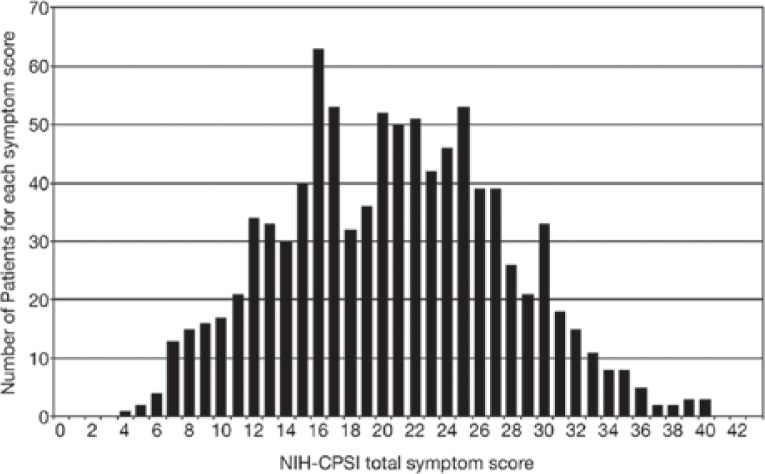
Distribution pattern of total National Institutes of Health-Chronic Prostatitis Symptom Index (NIH-CPSI) scores in the chronic prostatitis/chronic pelvic pain syndrome (CP/CPPS) patient population analyzed in this study. The vertical axis shows the total number of patients with a specific NIH-CPSI score.